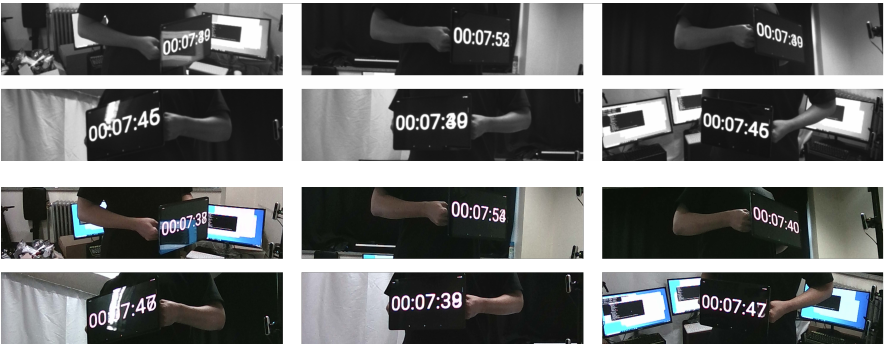
Figure 12. Qualitative evaluation of the proposed method. All digital clocks on the tablet show identical times.